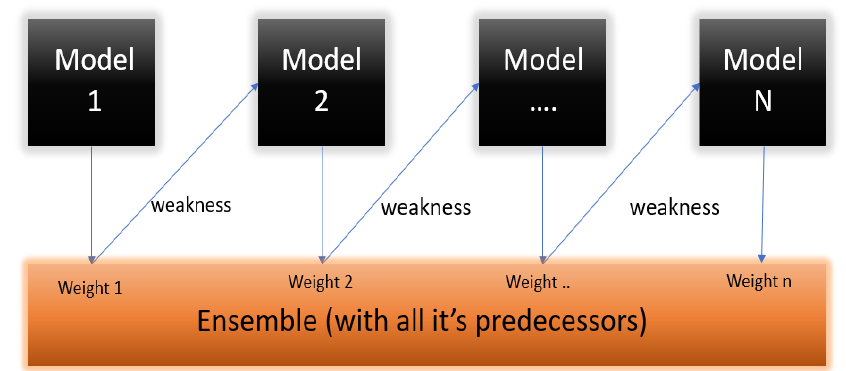
Figure 2. The boosting classifier in detail [25].